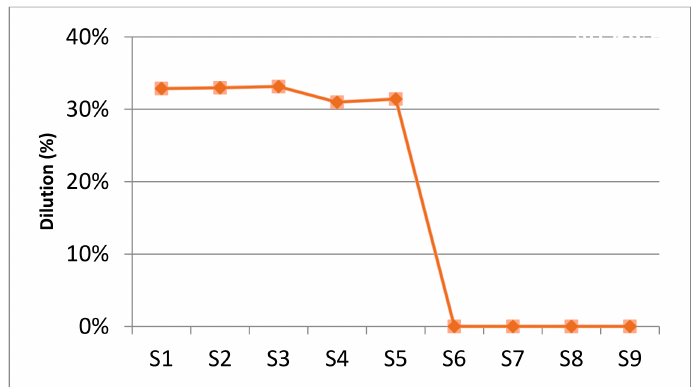
Figure 4. Comparison of dilution with the effect of heat treatment